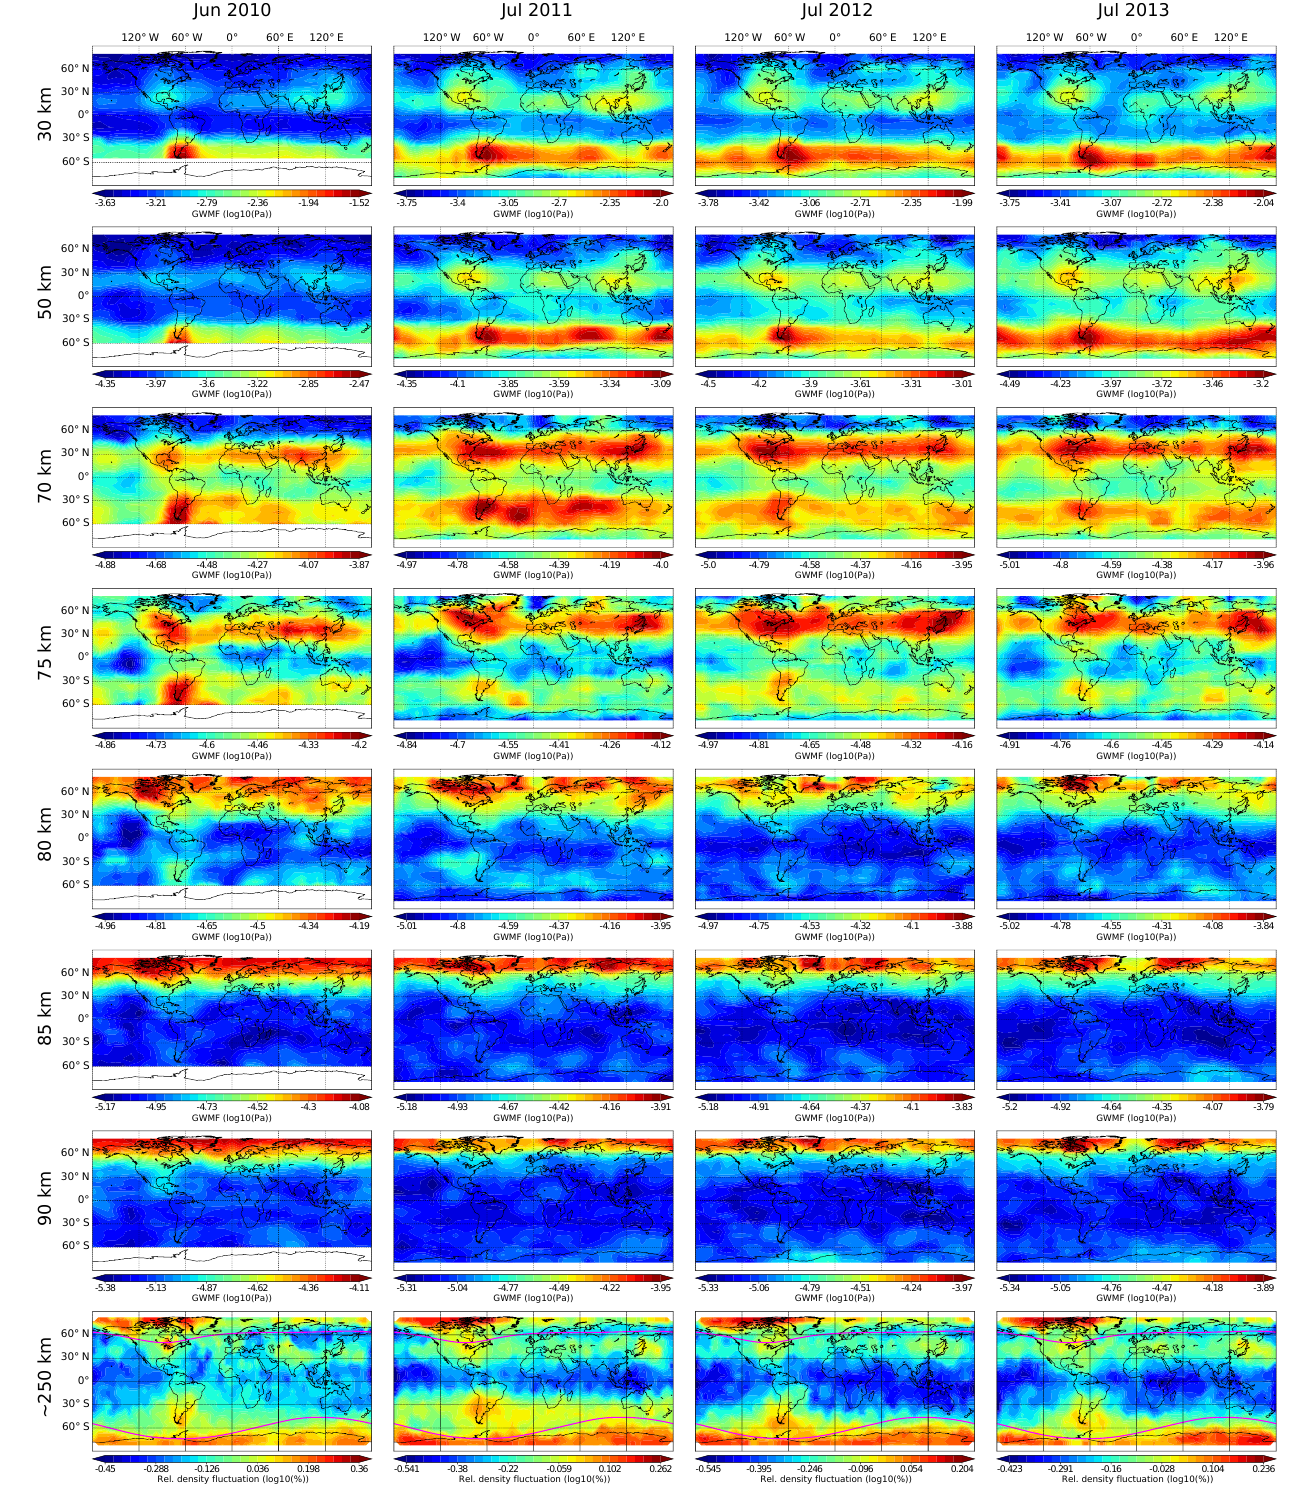
Figure 2. Global maps of GWMF derived from SABER observations (1st–7th rows) and ARDF derived from GOCE observations (last row) for boreal summer. Only data equatorward of 60 ◦ magnetic latitudes (magenta lines) on GOCE global maps are used for calculating